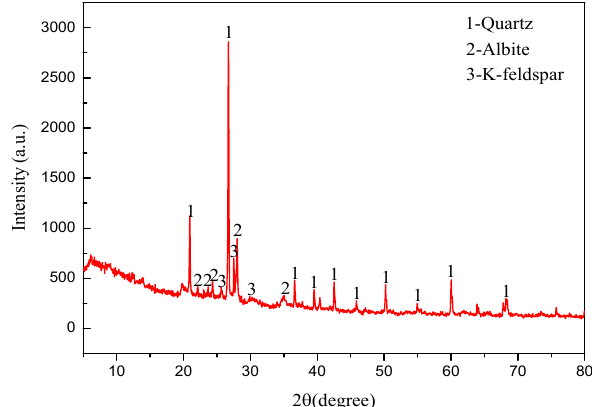
Figure 2. Original XRD spectrum of the tested soil.